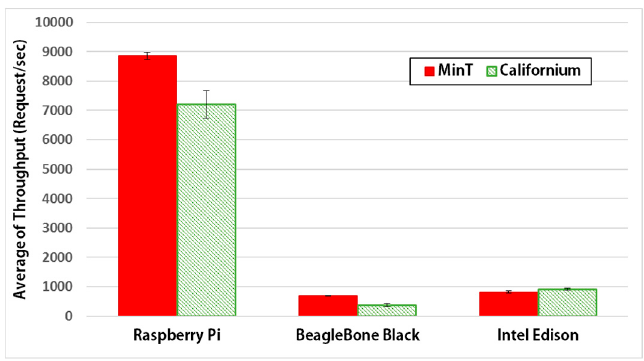
Figure 18. Average throughput performance on various hardware platforms for MinT and Californium